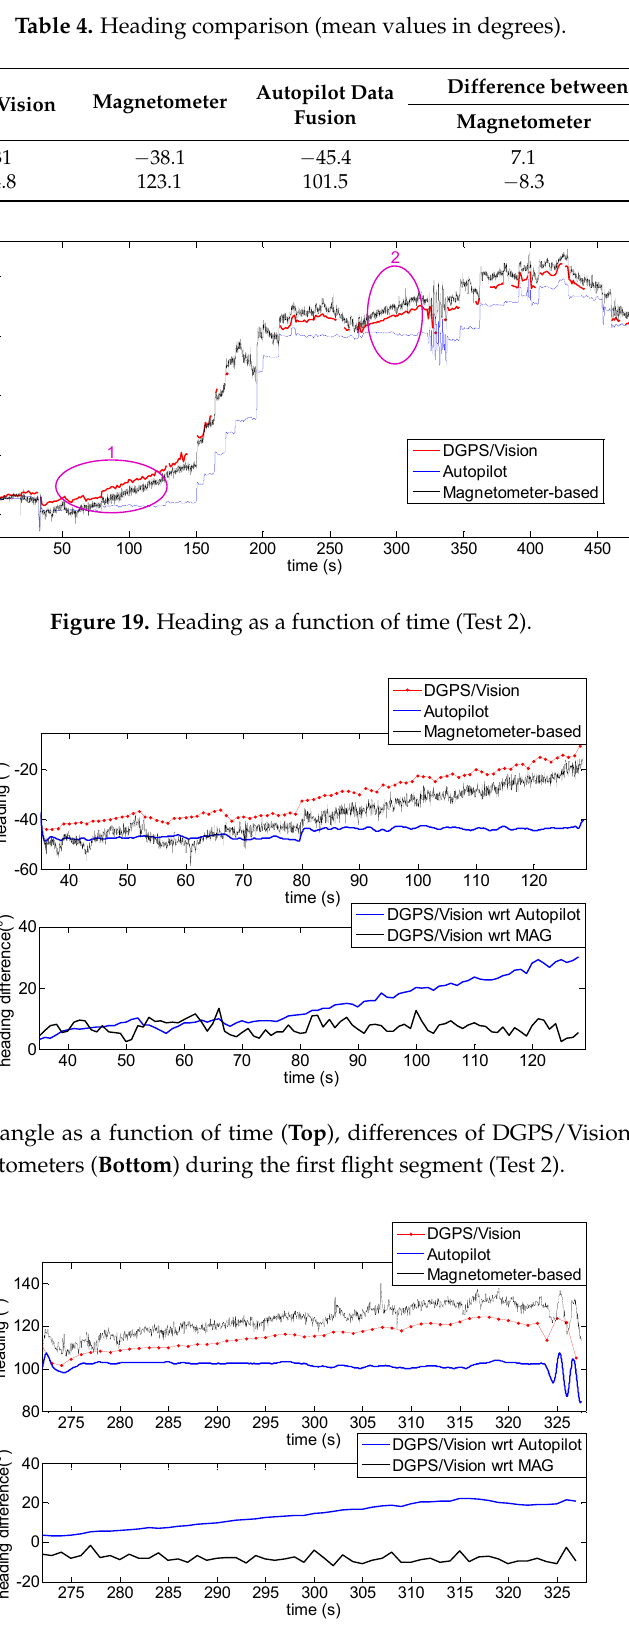
Figure 21. Heading angle as a function of time ( Top ), differences of DGPS/Vision with respect to autopilot and magnetometers ( Bottom ) during the second flight segment (Test 2). Table 4. Heading comparison (mean values in degrees).